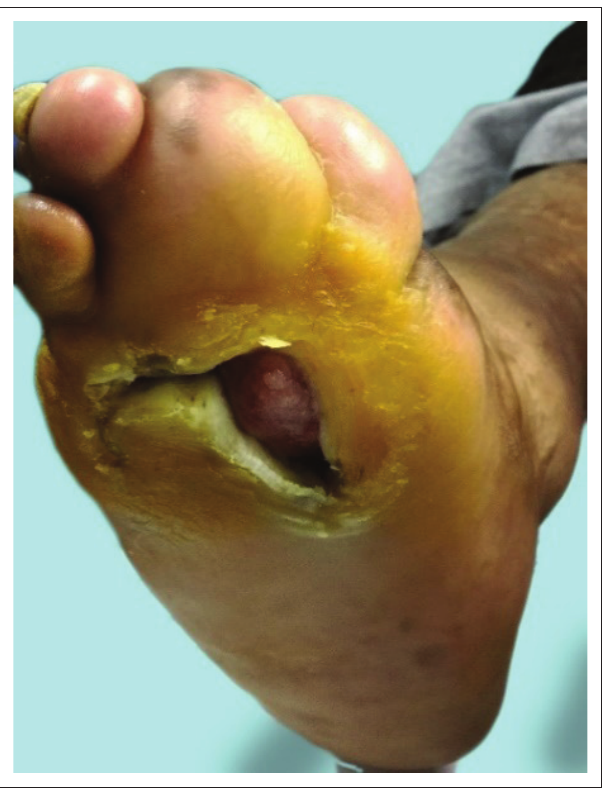
FIGURE 6: Neuropathic ulcer.